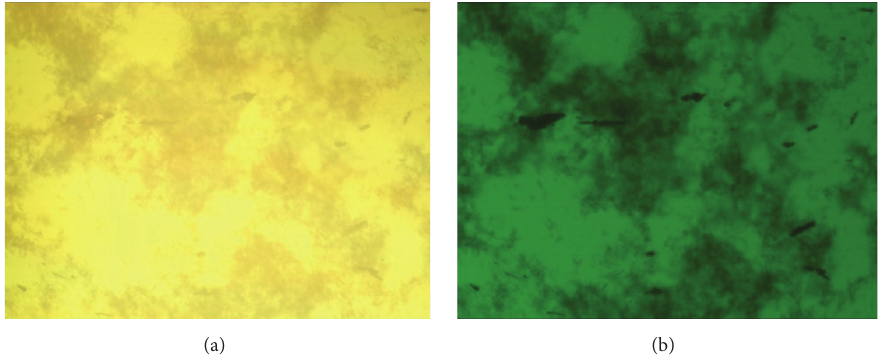
Figure 6: Photos of ferrographic record for sample C: (a) bottom light, (b) upper